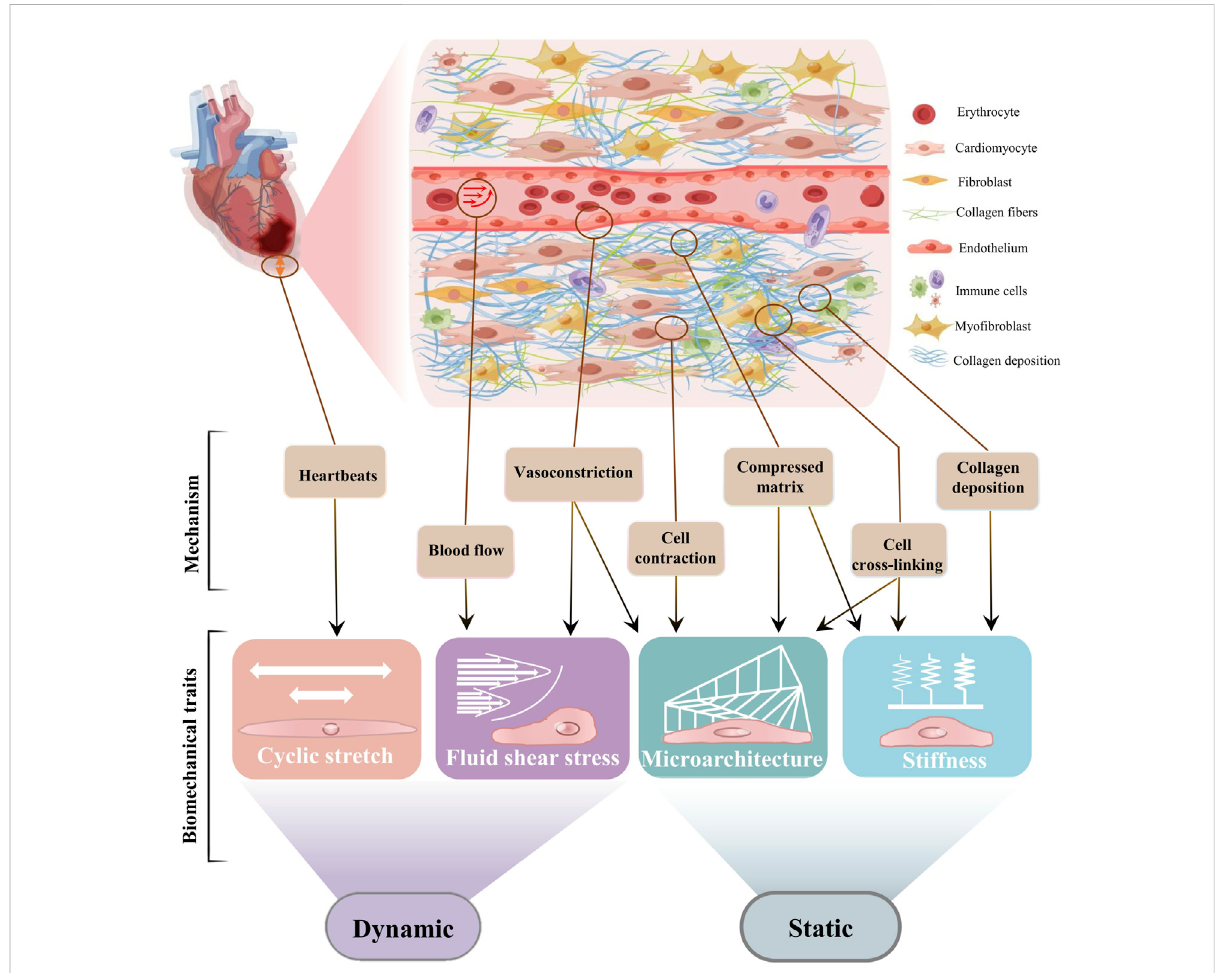
FIGURE 1 The biomechanical traits of cardiac fi brosis. Schematic diagram of cardiac fi brosis ECM was drew online using Figdraw. According to recent progresses of biomechanics, we recommend respectively from two biomechanical types to understand cardiac fi brosis. The fi brotic area must be subjectedtoastretchforcebecauseofthebeatingoftheheart.Themicroarchitectureandthe fl uidshearstressarethemechanicalstresscontained and transmitted by the solid phase and the liquid phase, respectively. Stiffness is de fi ned as the ability of a material to resist deformation under external forces. The physical interaction between cardiac cells and ECM produces the physical features of cardiac fi brosis through different and interrelated mechanisms.Theabnormalcontractionandrelaxationoftheheartcausevascularstretchtoincreaseblood fl uidpressurewithinthesite of fi brosis. Cell differentiation, increased fl uid shear stress, and matrix deposition result in compressive microarchitecture. Cardiac stretch, matrix deposition, and cross-linking can respectively lead to increased stiffness at the fi brotic site. The microarchitecture leads to the stretching and alignment of the matrix, and tissue stiffening increases the differentiation of cardiac fi broblasts. Fluid fl ow and excessive strain activate fi broblasts, which then contribute to increased cardiac wall stress and stiffness values and changes in ECM